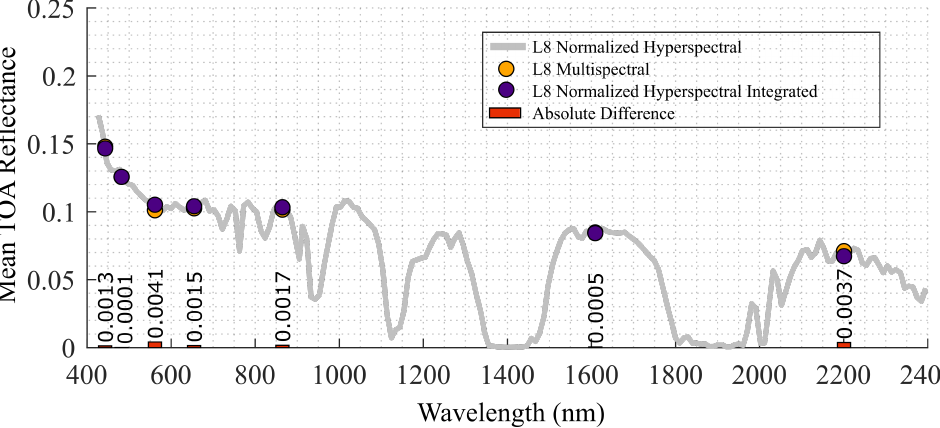
Figure 13. Showing L8 normalized hyperspectral TOA reflectance (grey curve), L8 multispectral TOA reflectance (orange circle), L8 normalized hyperspectral integrated TOA reflectance (purple circle), and absolute difference (red bar): after relative